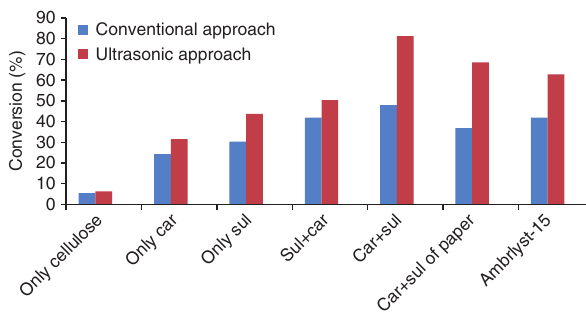
Figure 6 Comparison of different catalysts for the effectiveness in biodiesel production. Reaction temperature 60 ° C; molar ratio PFAD:methanol 1:6; Time 3